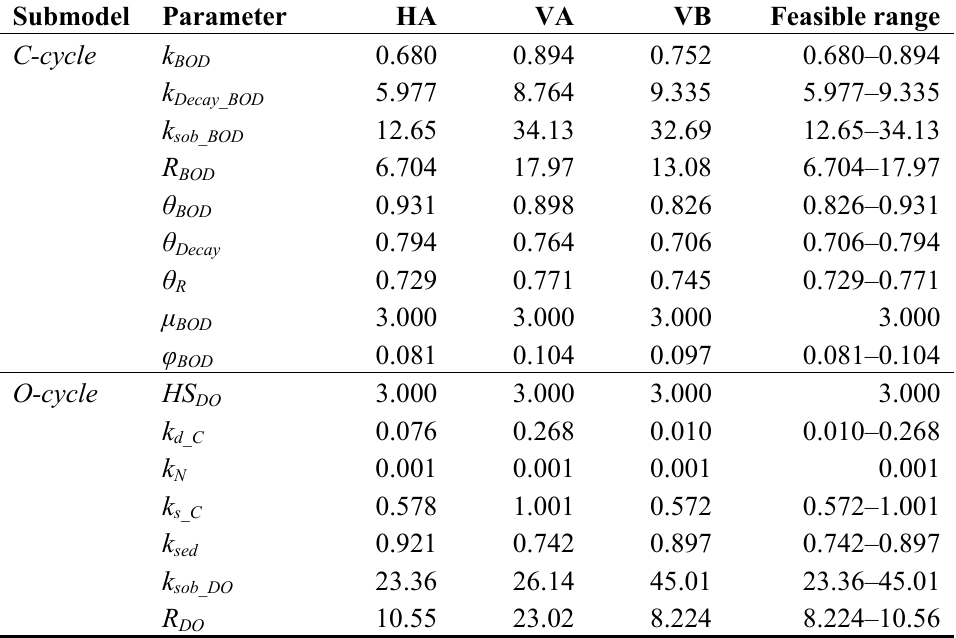
Table 9. Feasible range of parameters in the oyster-shell bedded